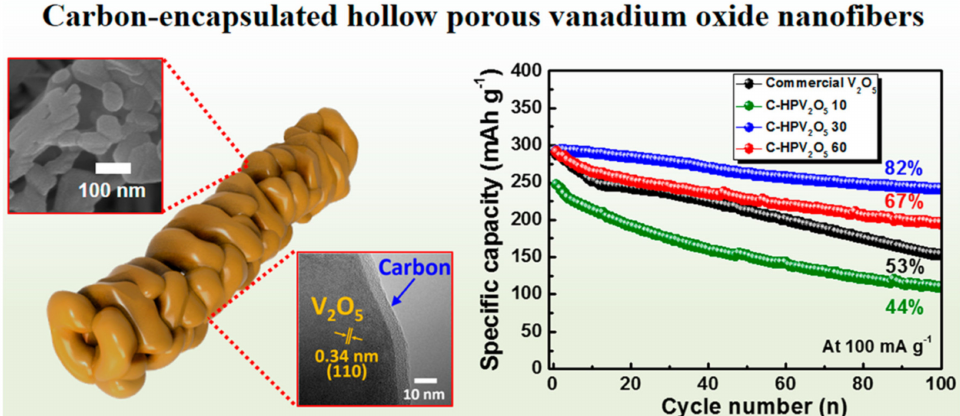
Figure 19. Images and specific capacity of carbon / porous hollow V 2 O 5 fibers calcined for di ff erent time. Reprinted with permission from [137]. Copyright © 2016 America Chemical Society.